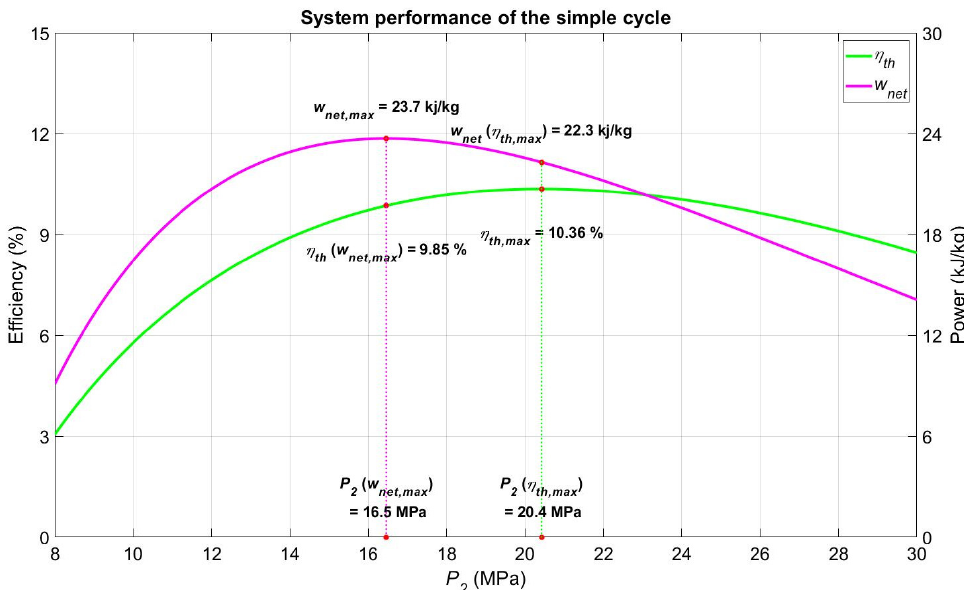
Figure 4. System performance of the simple cycle regarding P 2 ( T h , in = 150 ◦ C; η p = η e = 80%).